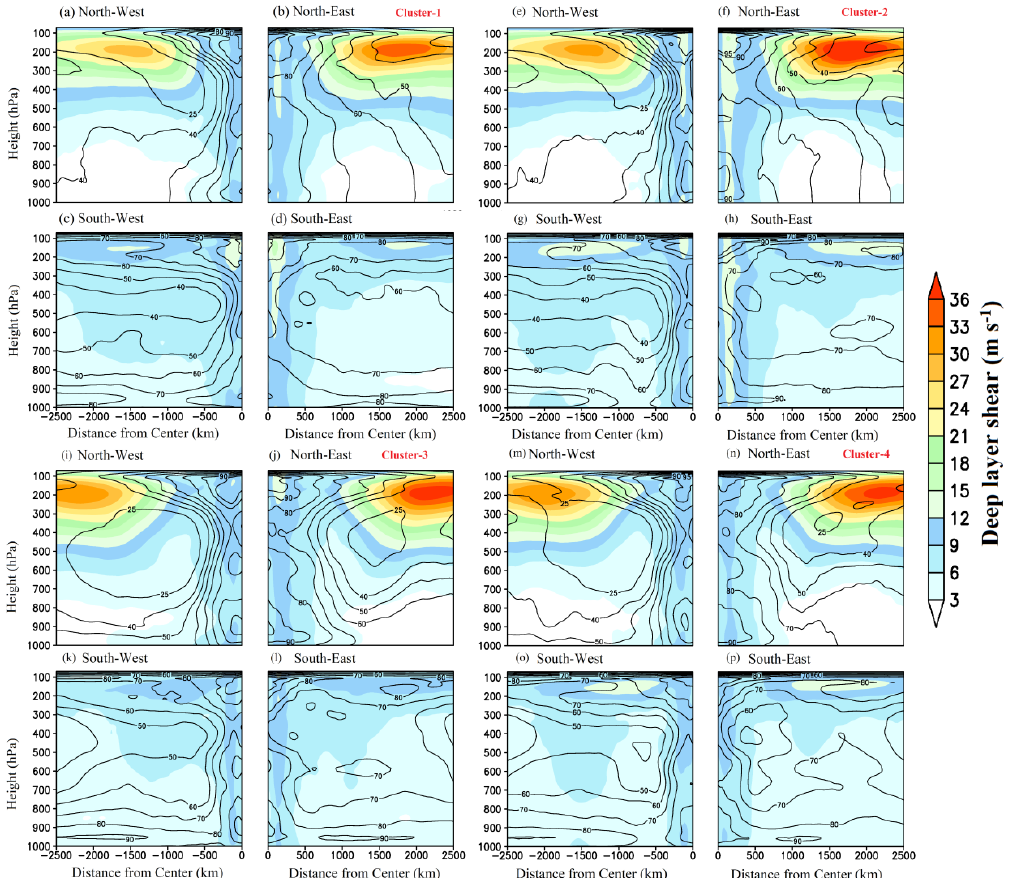
Figure 6. Radial-height cross-section of azimuthally averaged wind shear (shaded, m s −1 ) and relative humidity (contours, %) shown in each quadrant of the north-west (NW), north-east (NE), south-west (SW), and south-east (SE) from the vortex centre using ERA5 data for Cluster-1 ( a – d ), Cluster-2 ( e – h ), Cluster-3 ( i – l ), and Cluster-4 ( m – p